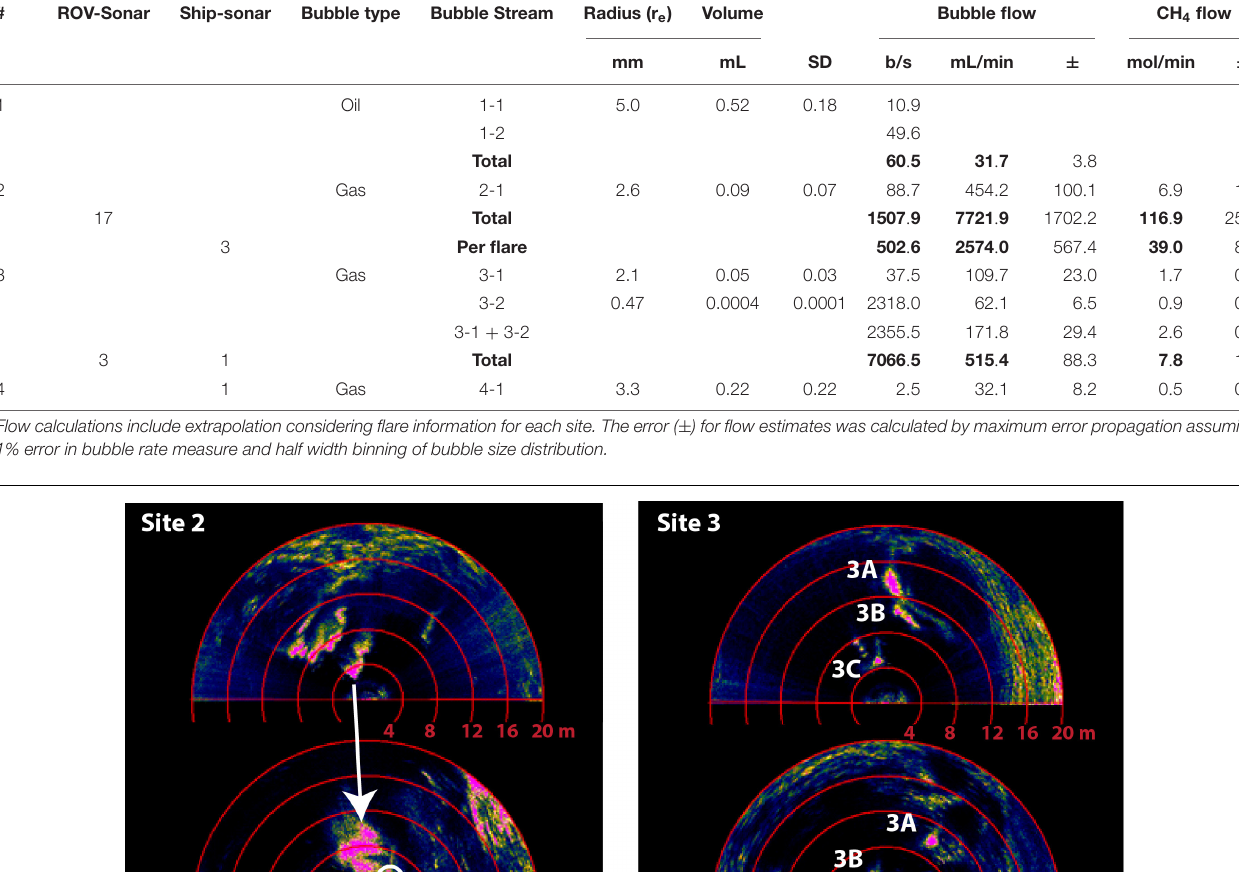
TABLE 2 | Bubble estimates and calculated flows at the four emission sites (Sites 1–4) in the main seep field at Tsanyao Yang Knoll. Site